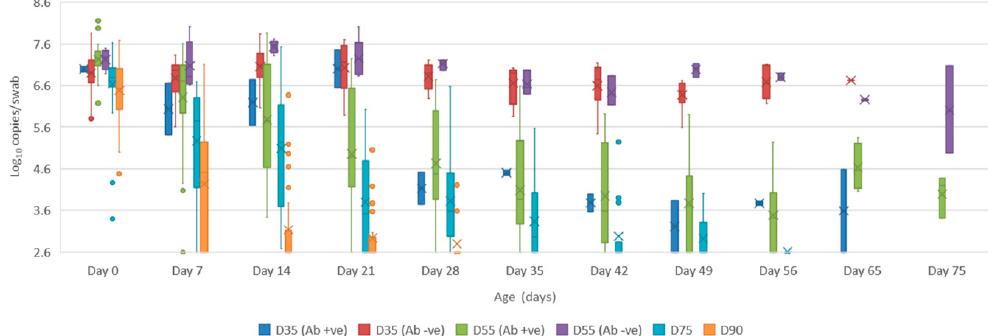
Figure 3. Box and whisker plot summarising the antibody titre against Bungowannah virus in serum as measured by peroxidase-linked immune assay between 0 to 75 days of age following in utero infection at one of four stages of gestation (x = mean; — = median; the whiskers extend up from the top of the box to the largest data element that is less than or equal to 1.5 times the interquartile range (IQR) and down from the bottom of the box to the smallest data element that is larger than 1.5 times the IQR. Values outside this range are considered outliers and are represented by dots).